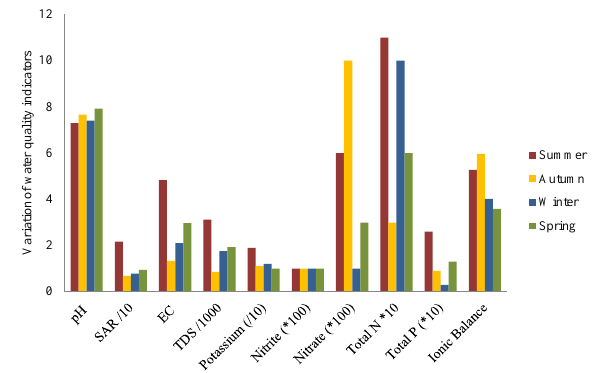
Fig. 6. Seasonal water quality indicators through cumulative drainage. Fig 6. Seasonal water quality indicators through cumulative drainage 661 Table 3. Seasonal variation of drainage quality indicators in Veale Gardens (kgha − 1